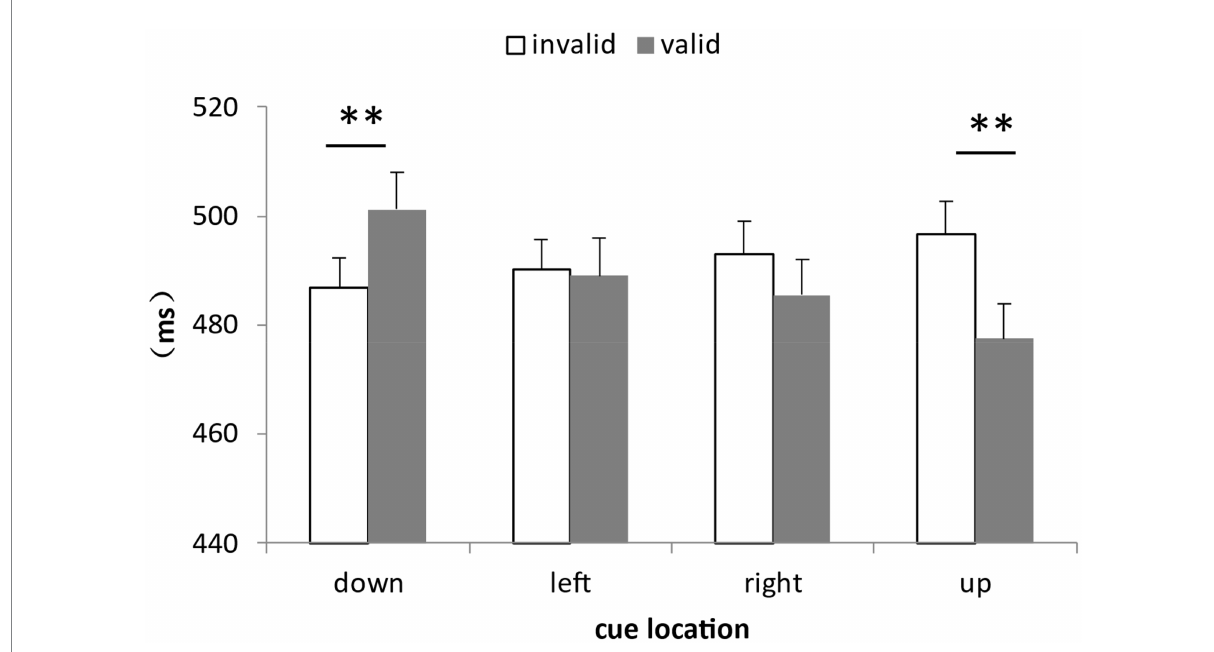
FIGURE 6 Interaction between cue validity and cue location in Experiment 2. When the cue appeared in the lower position, the response when the cue was invalid was faster than that when the cue was valid; when the cue appeared in the upper position, the response when the cue was invalid was slower than that when the cue was valid; and when the cue appeared on the left and right sides, there was no difference between the response when the cue was invalid and the response when the cue was valid (** p <